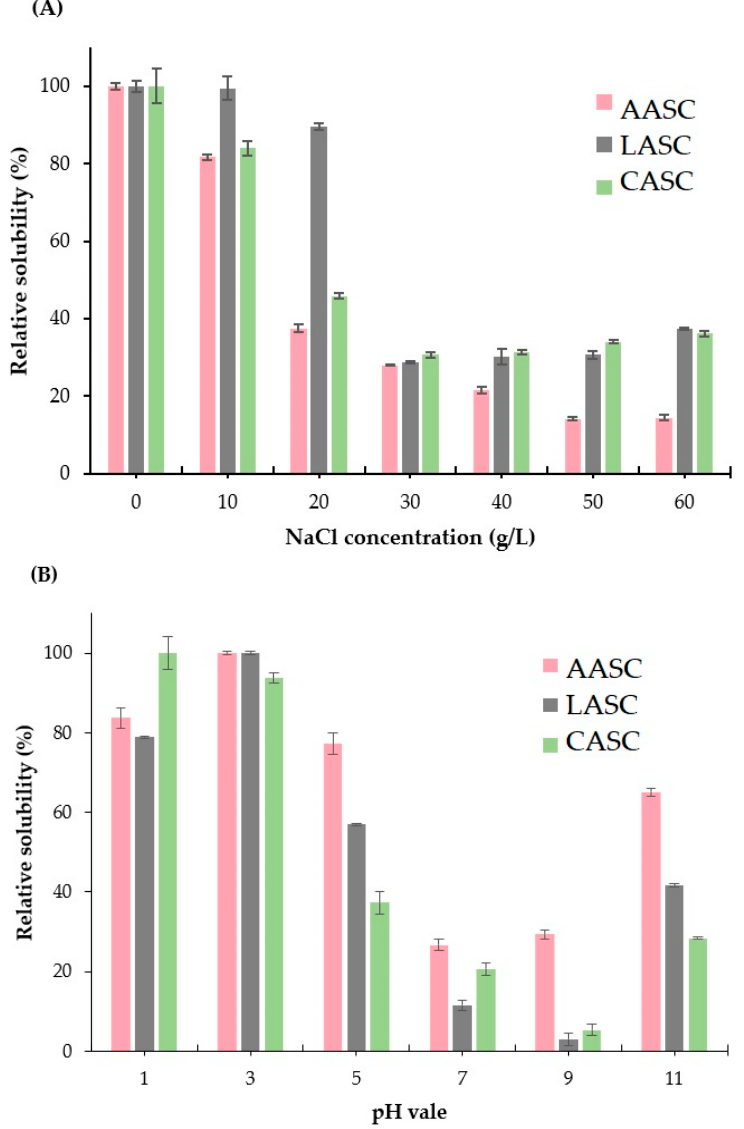
Figure 5. Relative solubility (RS) of acid soluble collagens from the unicornfish ( N. reticulatus ) bone at ( A ) different NaCl concentrations and ( B ) various pH levels. AASC: acetic acid soluble collagen; LASC: lactic acid soluble collagen; CASC: citric acid soluble collagen.